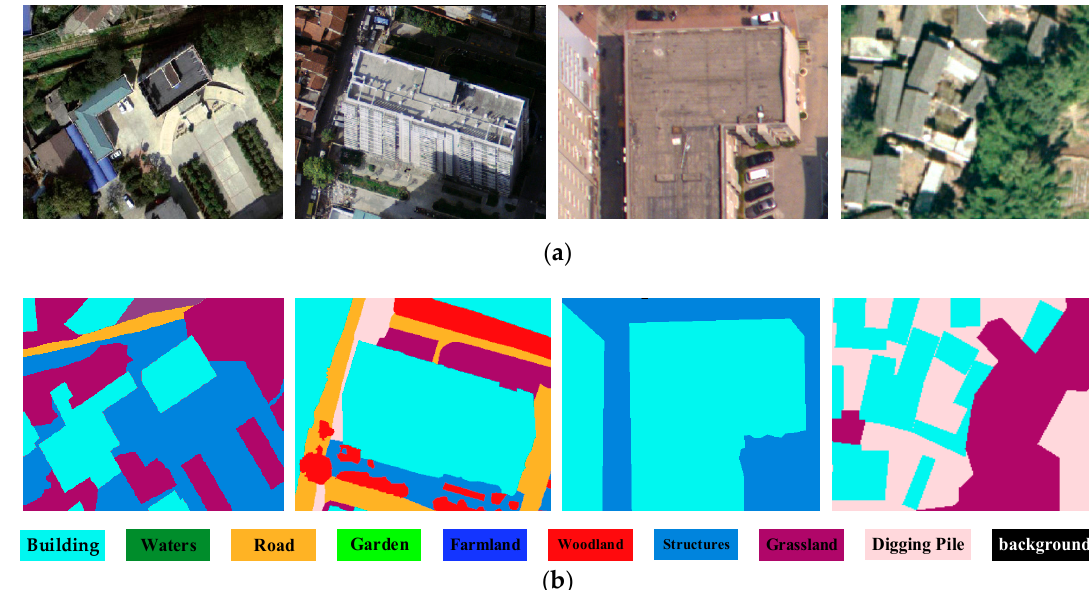
Figure 4. Examples of the training sample on the EvLab-SS dataset. ( a ) The RGB images, and ( b ) the corresponding label data.